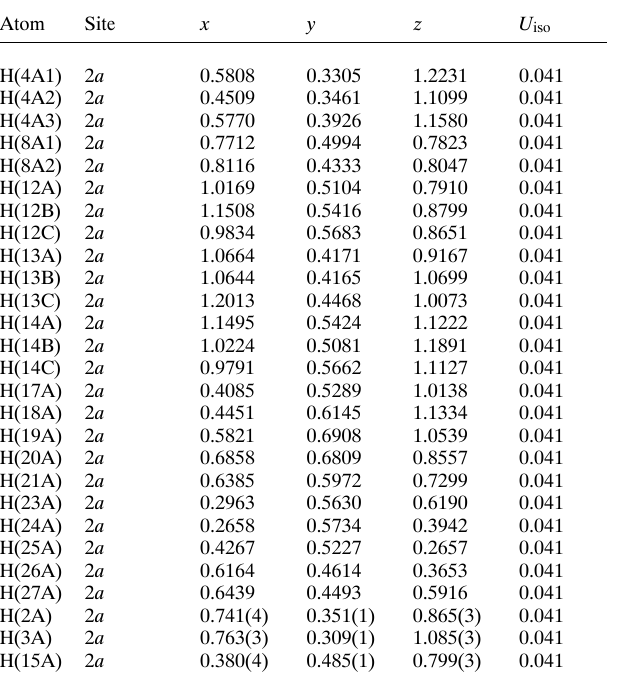
Table 2. A tomic coordin a tes a nd displ a cement p a r a meters (in Å 2 ) . Table 2. C